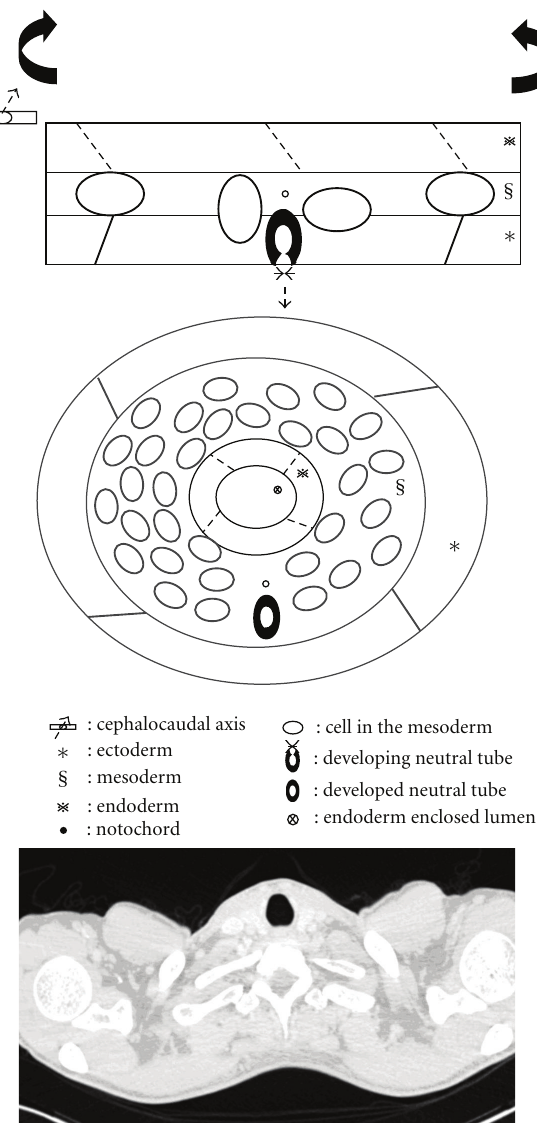
Figure 4: Lateral folding of germ disc in the level of pharyngeal arches. Diagram shows the cells in the mesoderm proliferates and neural tube is